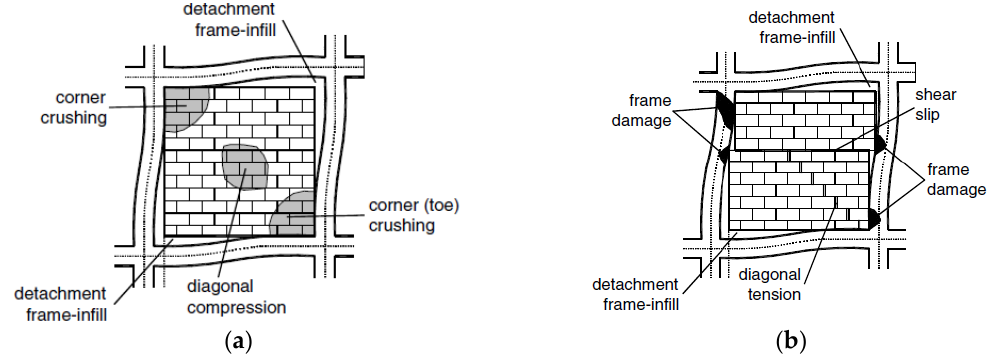
Figure 3. Different failure modes of reinforced concrete (RC) infilled frames: ( a ) corner crushing and diagonal compression, ( b ) diagonal tension and shear sliding (adapted from Asteris et al. [48]).